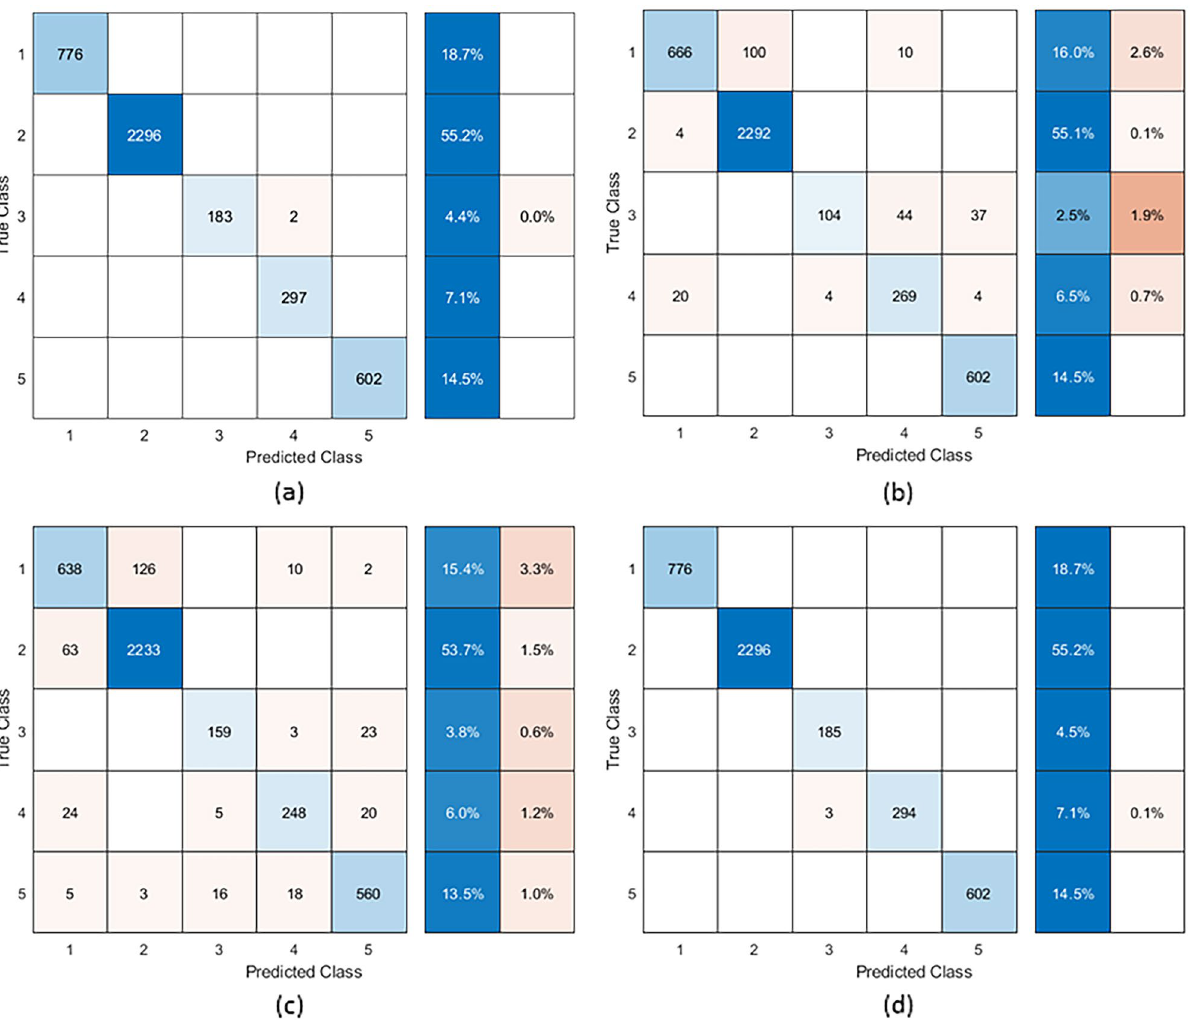
Figure 3. Confusion matrix of classifiers on chronic back pain classes (no pain-free controls included) with ( a ) Support Vector Machine, ( b ) Naïve Bayes, ( c ) k-Nearest Neighbour and ( d ) Random Forest classifiers. The x-axis is the predicted class while the y-axis is the true class. Blue squares indicate the number in the class that was accurately classified, while the oranges squares show the number of misclassifications. The boxes on the right of the matrix show the percentage of classification (blue) and misclassification (orange) for the class. Classes are (1) low social isolation and loneliness and moderate depressive symptoms (n = 776; 18.7%), (2) low loneliness/social isolation and depressive symptoms (n = 2296; 55.3%), (3) high loneliness/social isolation and moderate depressive symptoms (n = 185; 4.5%), (4) moderate loneliness/social isolation and high depressive symptoms (n = 297; 7.2%) and (5) moderate loneliness/social isolation and low depressive symptoms (n = 602;